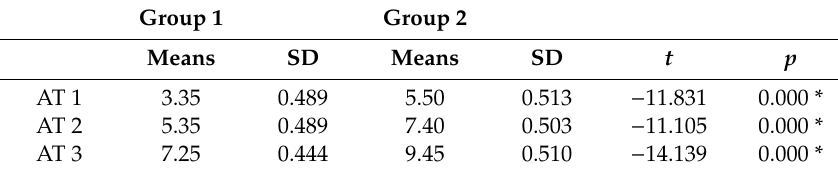
Table 3. Comparison of acquisition task (AT) between group 1 and group 2.